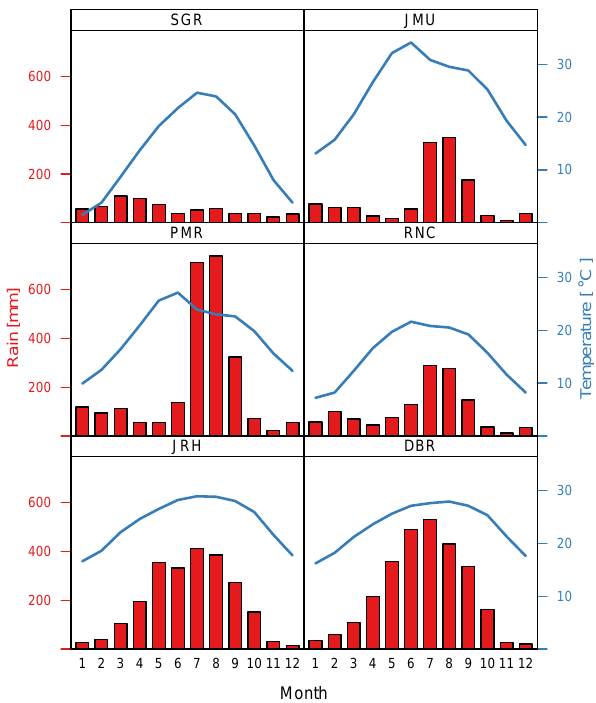
Figure 2. Long-term (1985–2014) monthly surface air tempera- ture and precipitation data for six stations where daily